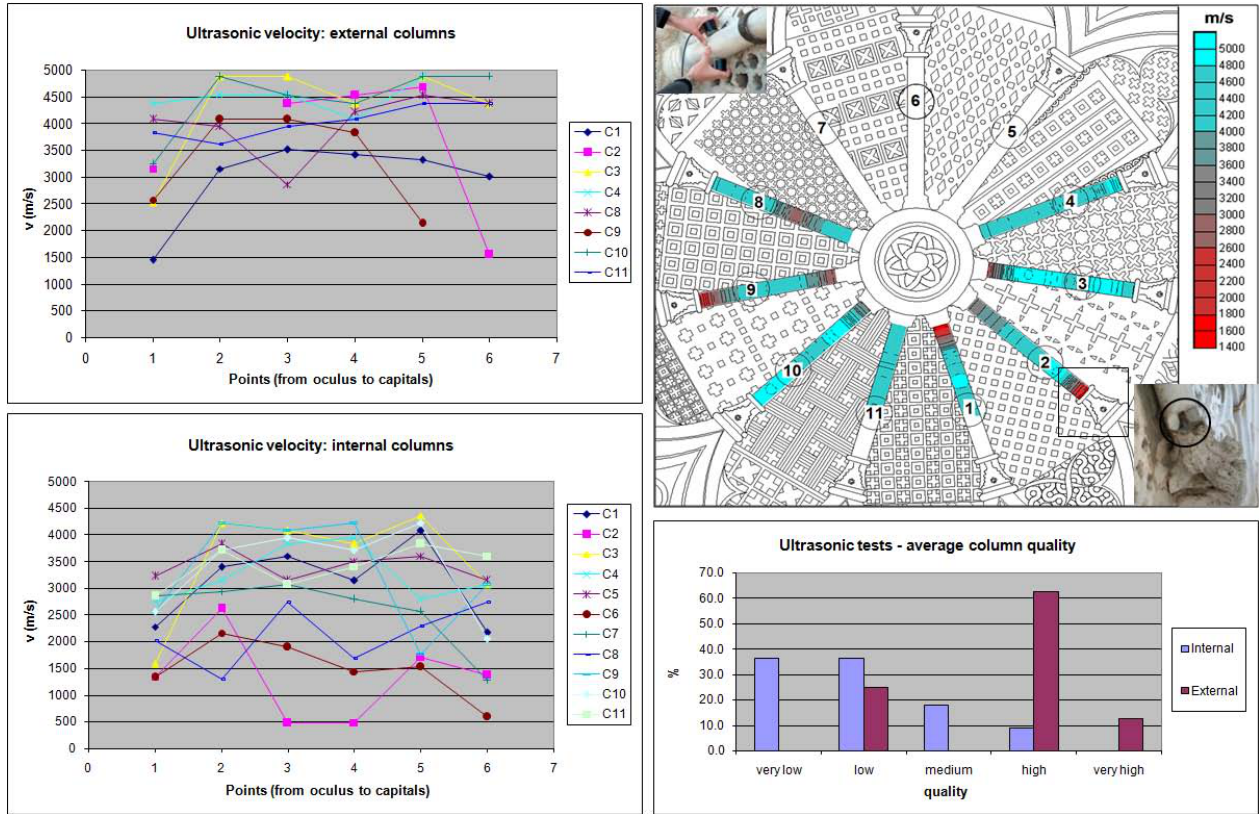
Fig. 4. (Left) Results of the ultrasonic tests on the external and internal columns. (Top-right) Ultrasonic velocity distribution on the external columns with (lower inset) example of low-velocity anomalies related to cracks or material detachment exposing a metallic anchor bolt. (Bottom-right) Column quality classification according to the ultrasonic